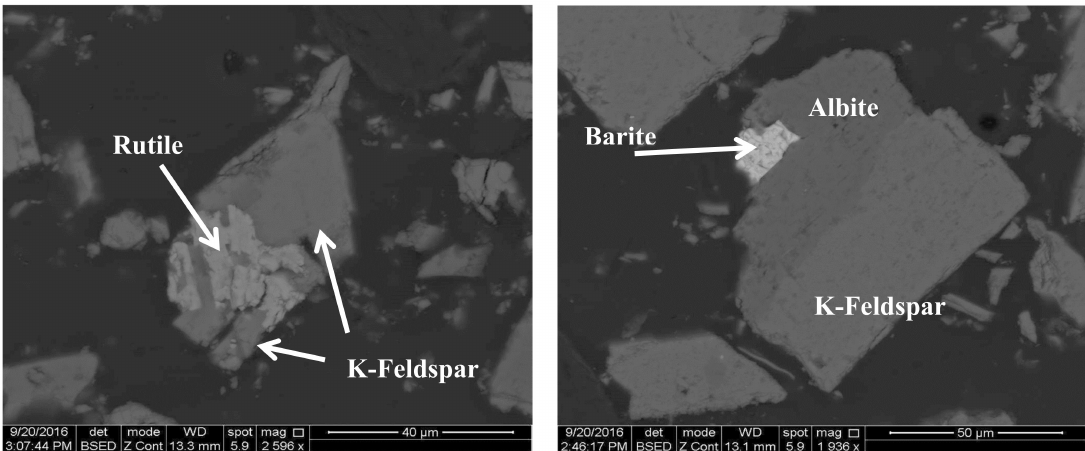
Figure 2. Backscattered electrons (BSE) images of the